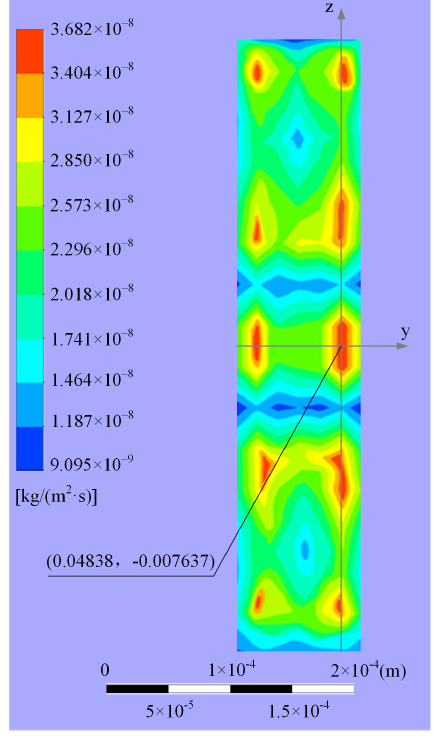
Figure 16. Erosion rates distribution on the shunt wedge.